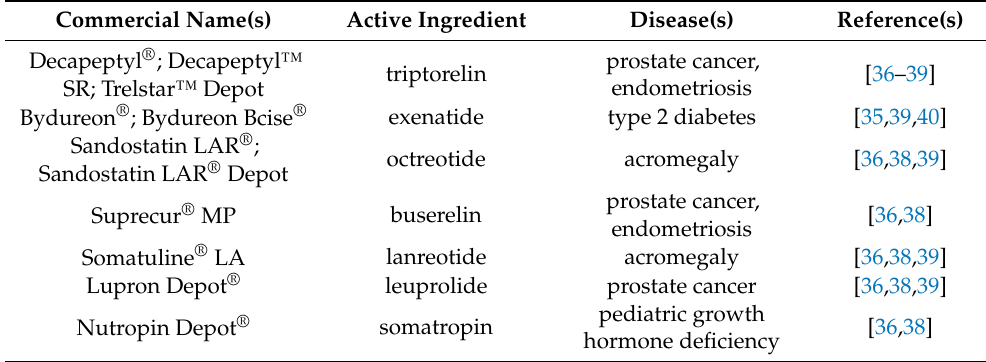
Table 2. Commercial formulations using PLGA particles for drug